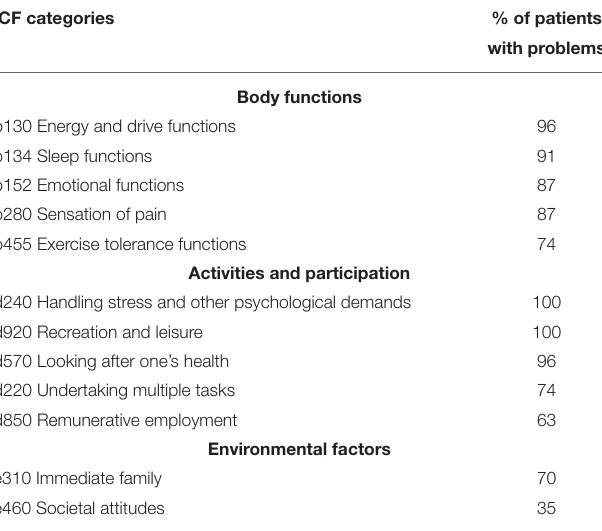
TABLE 4 | The five most frequently scored problem categories by the clinical team (qualifiers 1, 2, 3 and 4) in body functions and activities and participation and the two most frequently scored barrier categories in environmental factors related to functioning and work ability at posttest ( n =